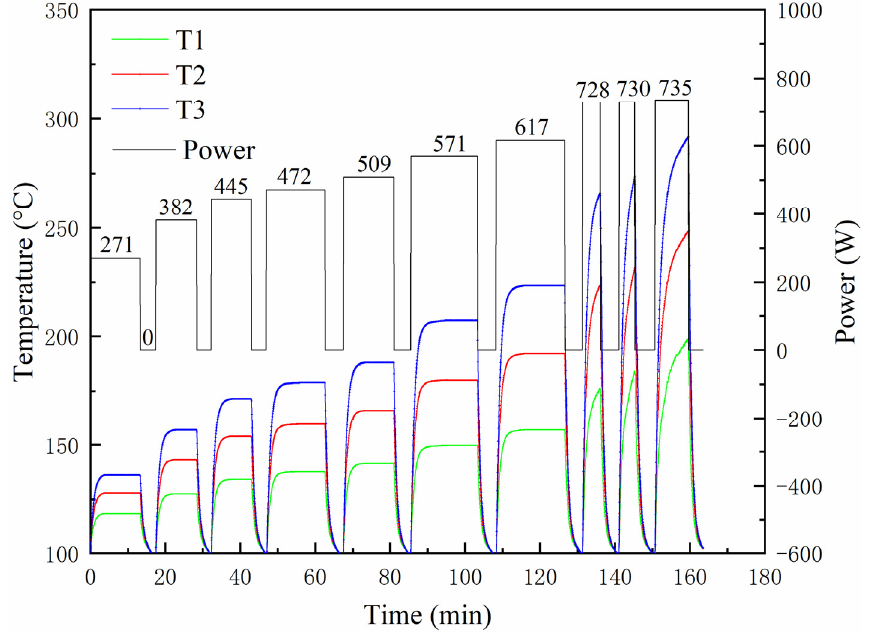
Figure 8. Temperature variation of different heat flux under intermittent heating mode.